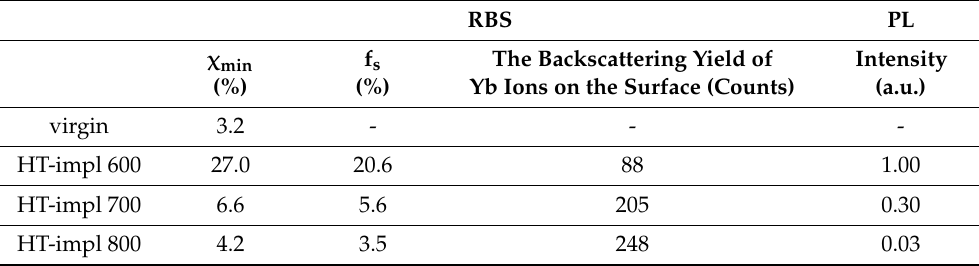
Table 1. Numerical evaluation of the RBS and PL spectra of ZnO implanted at different high temperatures with 150 keV Yb ions at the fluence of 1 × 10 15 /cm 2 .